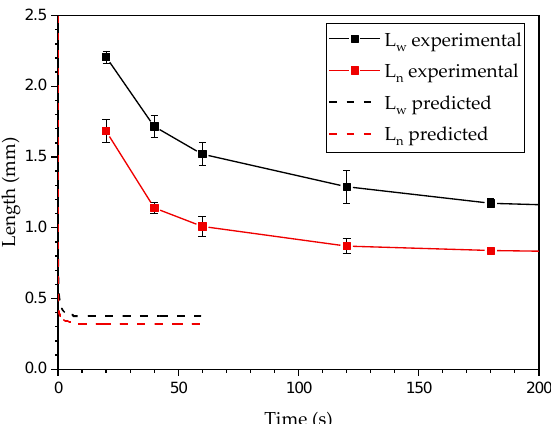
Figure 6. Length evolution result by a mechanistic model using an empirical excluded volume force constant, compared to the Couette flow experiments.